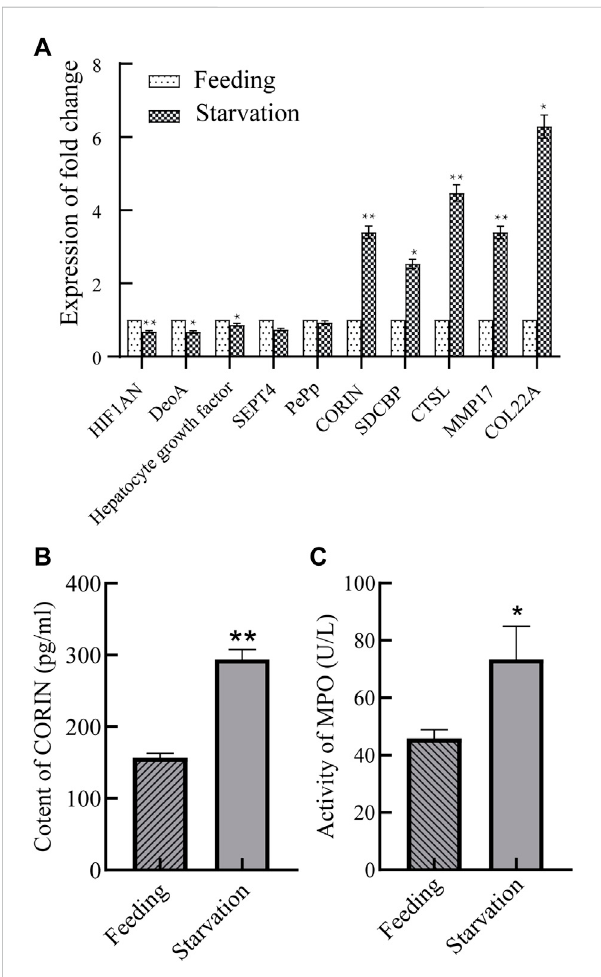
FIGURE 6 Expression changes of differentially expressed protein-coding genes (A) and changes of CORIN content (B) and activity of MPO in blood (C) . * p < 0.05 or ** p < 0.01 versus starvation